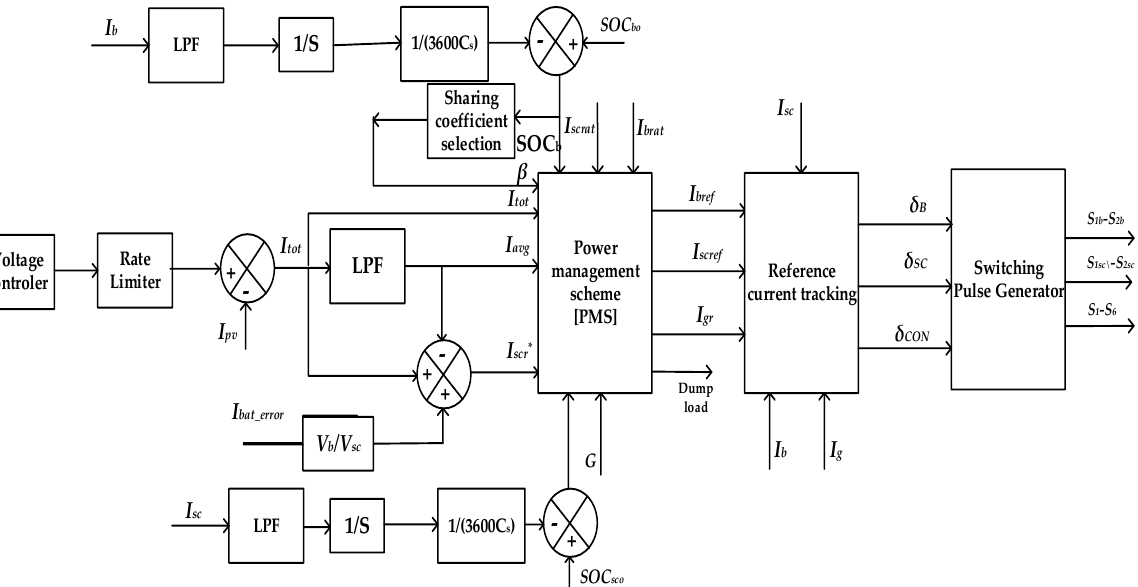
Figure 3. The overall control structure for the microgrid.